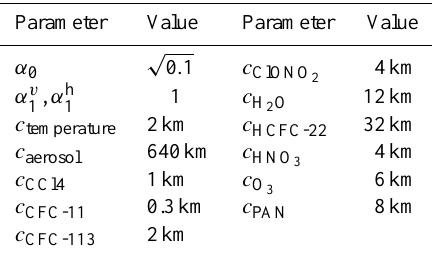
Fig. 3. Two cross-sections of CFC-11 and ClONO larisation and factor-200 horizontal regularisation.